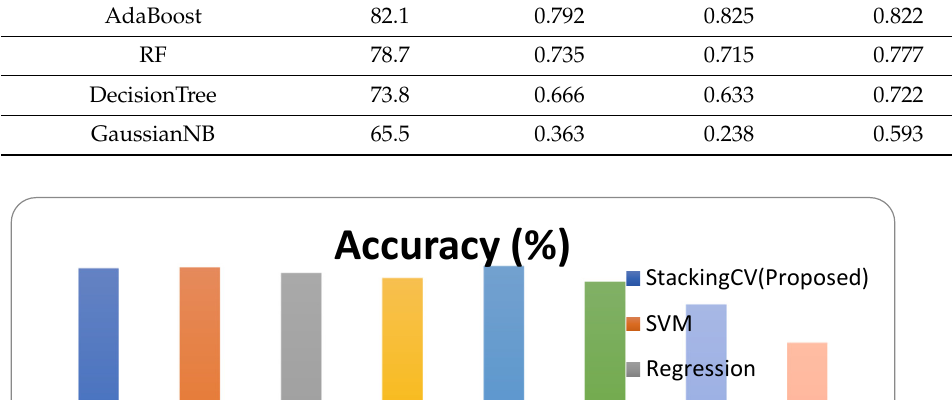
Table 3. Performance evaluation of the system for the Xception feature extraction method.